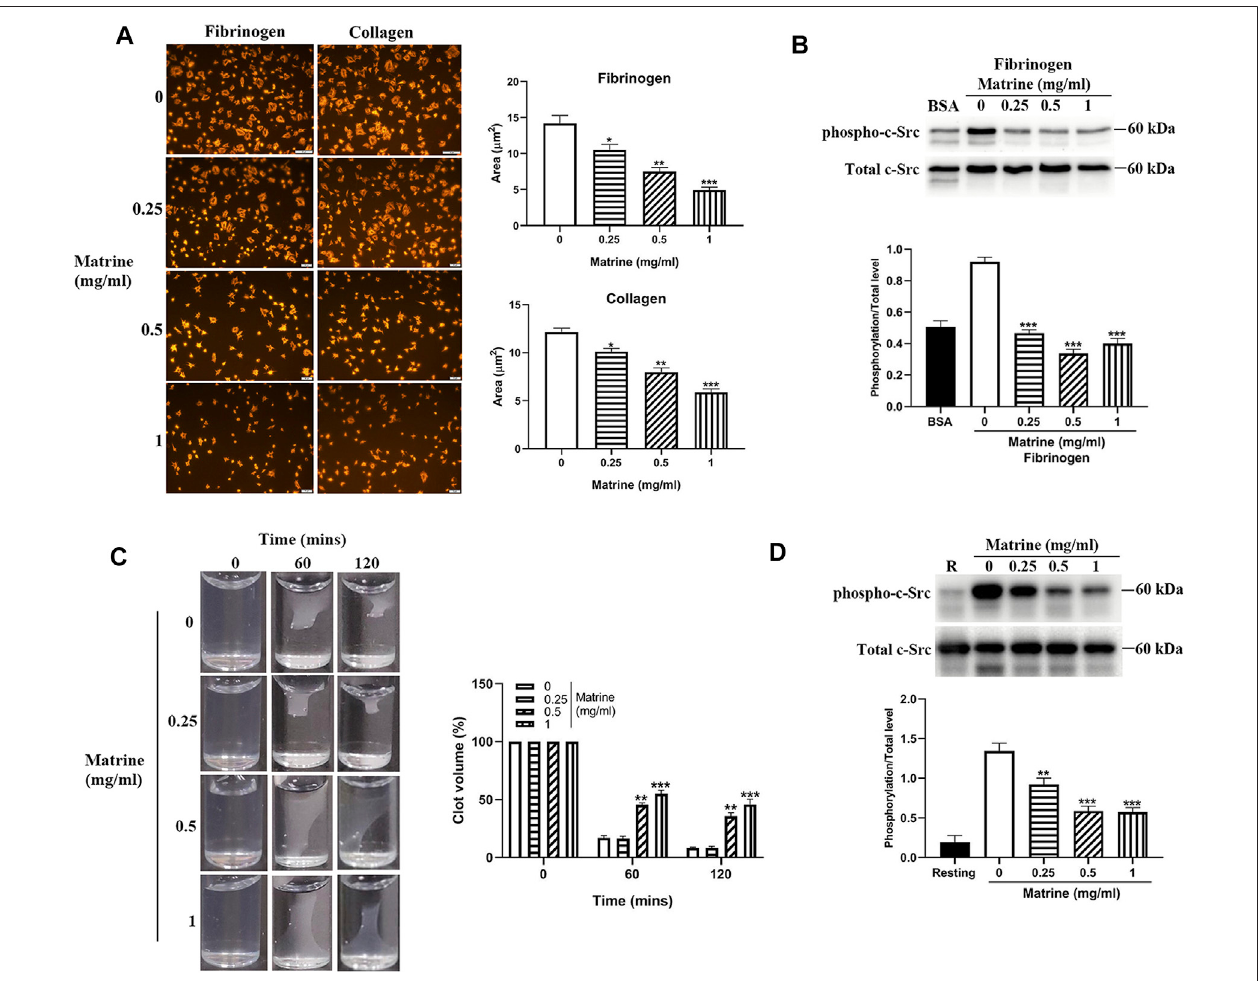
FIGURE 3 | Platelet spreading and clot retraction. After matrine treatment, platelets were placed on fi brinogen or collagen coated glass coverslips and allowed to spread at 37 ° C for 90 min followed by staining with Alexa Fluor-546-labelled phalloidin (A) (mean ± SE, n (cid:2) 3) or measurement of c-Src phosphorylation by western blot (mean ± SD, n (cid:2) 3) (B) .Clotretractionwasinitiatedinmatrine-treatedplateletsinthepresenceof2 mMCa 2+ and0.5 mg/ml fi brinogenafteradditionofthrombin(1 U/ml). Images were captured every 30 min (mean ± SD, n (cid:2) 3) (C) . Under clot retraction condition, the phosphorylation level of c-Src was measured by western blot and represented as a ratio relative to the total level (mean ± SD, n (cid:2) 3) (D) . BSA: bovine serum albumin. Compared with 0, * p < 0.05; ** p < 0.01; *** p <